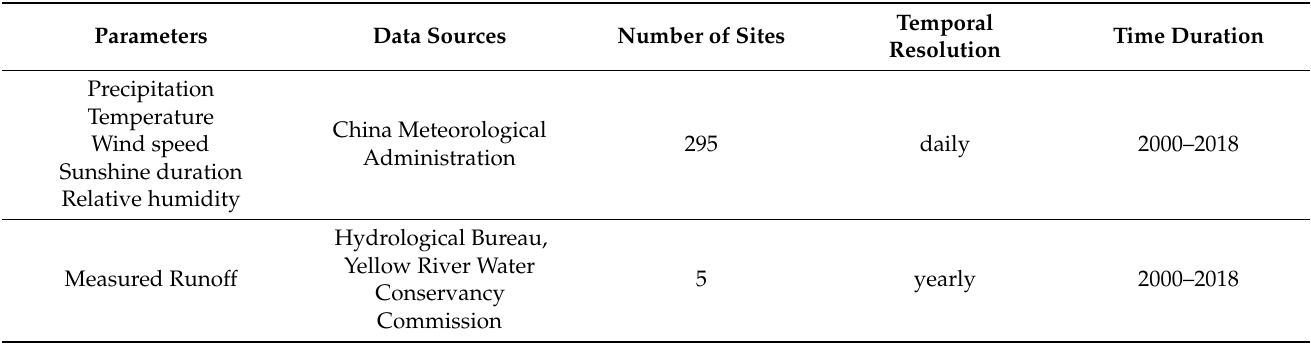
Table 2. Field observation datasets used in this